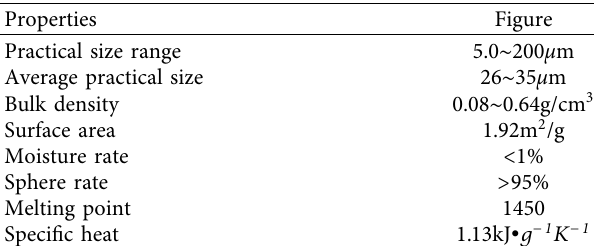
Table 2: Physical properties of